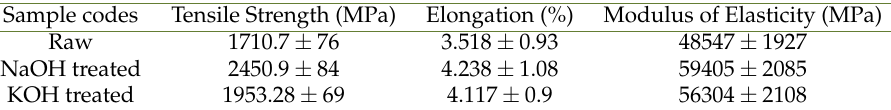
Fig. 7. SEM images of PFs, (a-b) raw, (c-d) NaOH treated and (e-f) KOH treated. Table 4. Mechanical properties of raw, NaOH and KOH treated